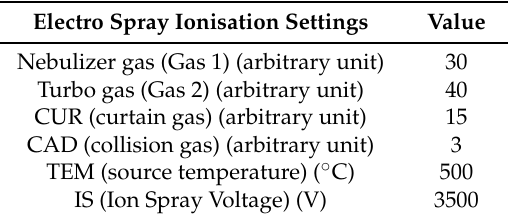
Table 5. Ionization source